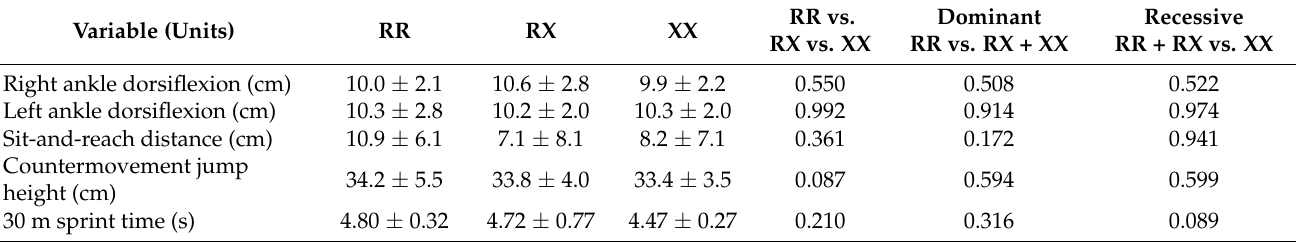
Table 2. Physical performance variables in women football players competing in the first division of Spanish football according to their ACTN3 R577X